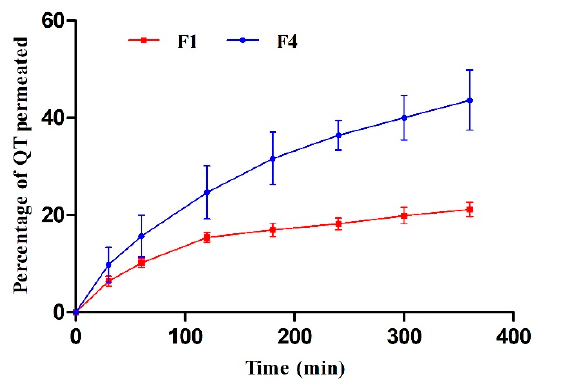
Figure 4. Representative graphs of the cumulative amounts of QT permeated through full thickness skin samples versus time for F1 and F4 (mean values ± SD, n = 3).